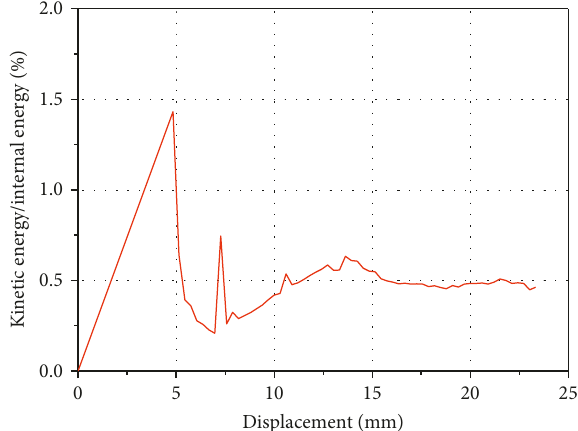
Figure 11: Ratio of the kinetic energy to the internal energy of specimen TS75-100.